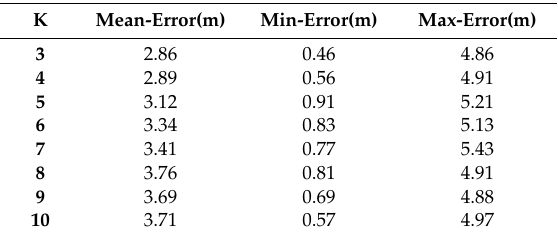
Table 3. Positioning error of the different K values.